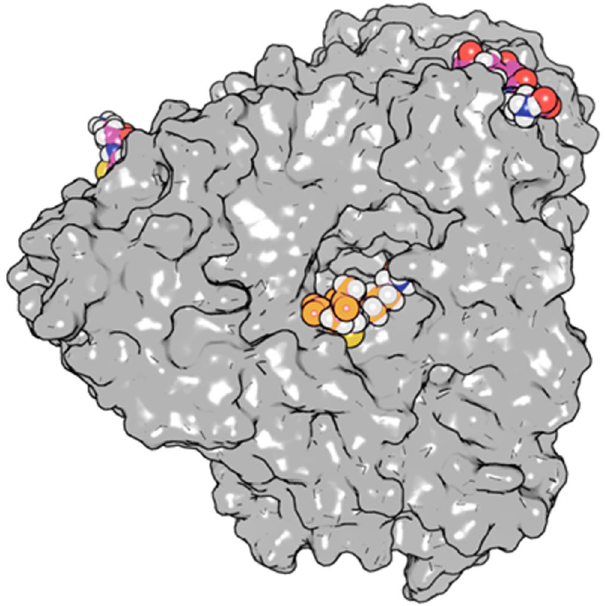
Figure 8. CPC molecules bound to the CA surface and to the gatekeeper residues. The protein surface is represented in grey while CPC molecules are represented in sphere mode. The CPC molecule in the center (orange) is bound to the gatekeeper residues at the entrance to the binding